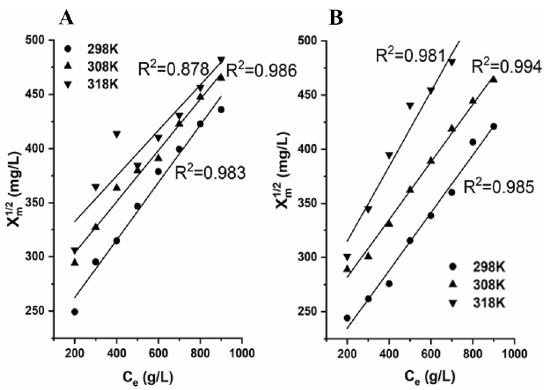
Fig. 4 Flocculation model fitting results of OL‑PS‑DVB ( A ) and MA‑PS‑DVB ( B )